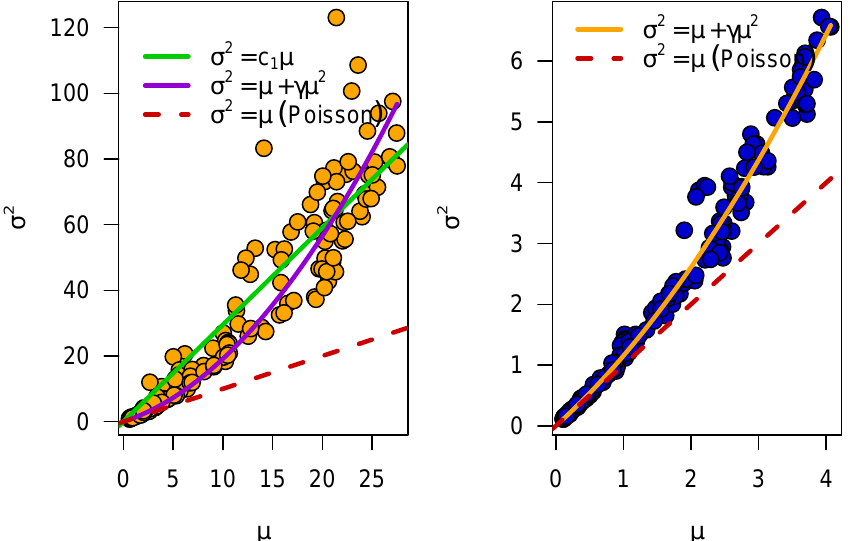
Figure 4. Variance versus mean for all crashes ( left ) and the severe crashes ( right ). For comparison, a linear relationship is fitted as well, and the theoretical Poisson result is also included (broken red lines).